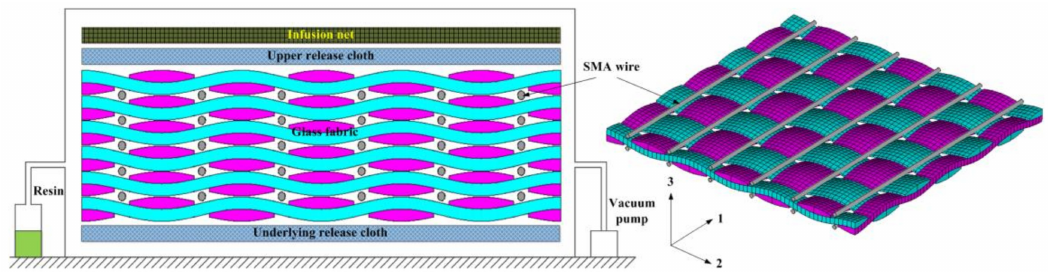
Figure 3. Illustration of the vacuum-assisted resin injection (VARI) installation and stacking pattern of the SMA wires and